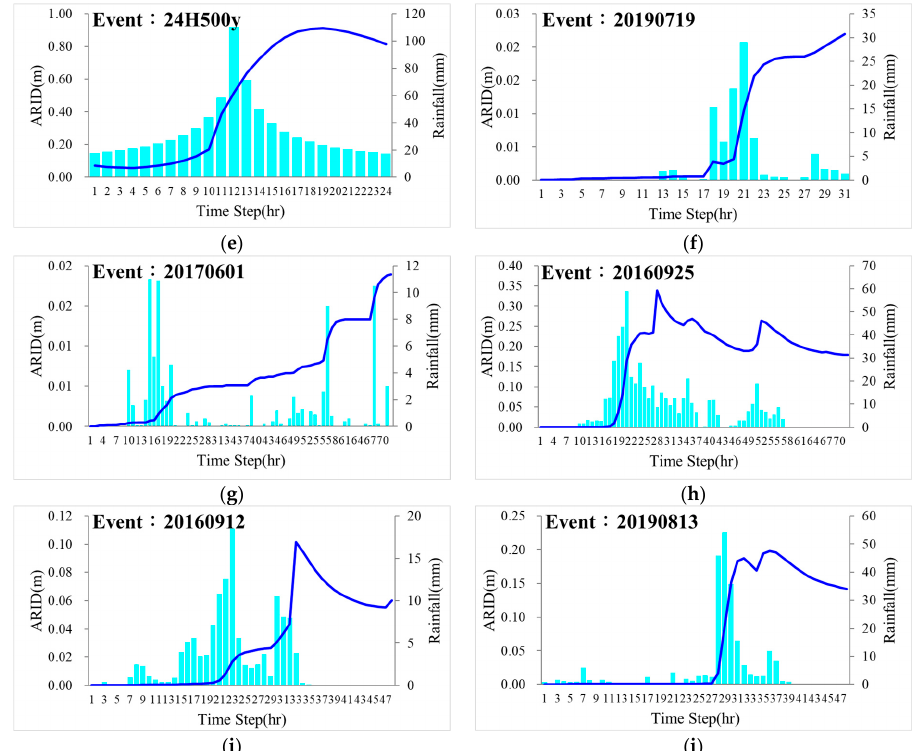
Figure 3. Rainfall histogram and average regional inundation depth hydrograph for training events.